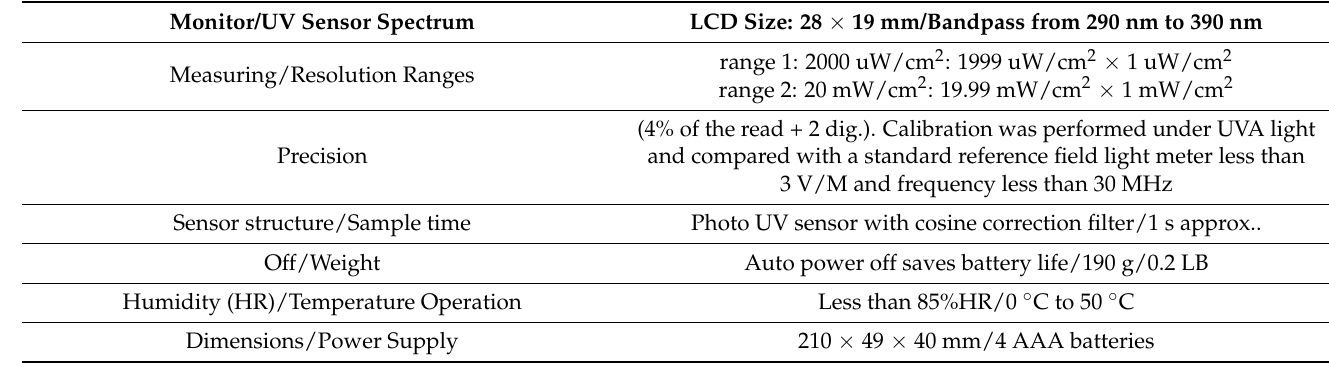
Table 1. Technical specifications of meter PUV-360.